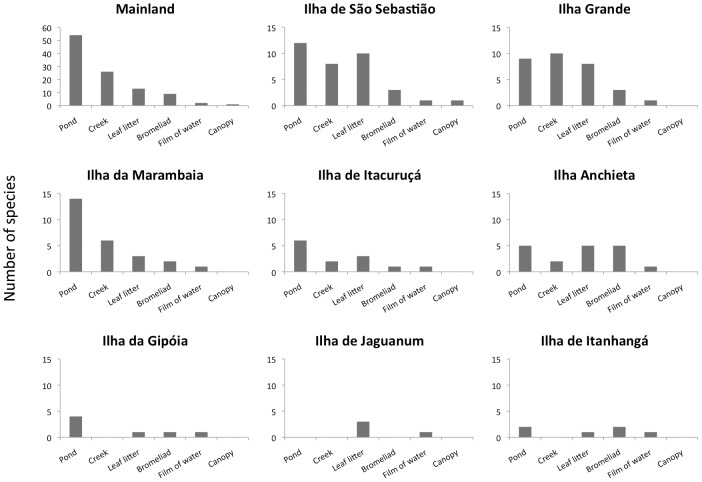
Use of breeding habitats by anuran species, not considering the macro-habitats where they occur.